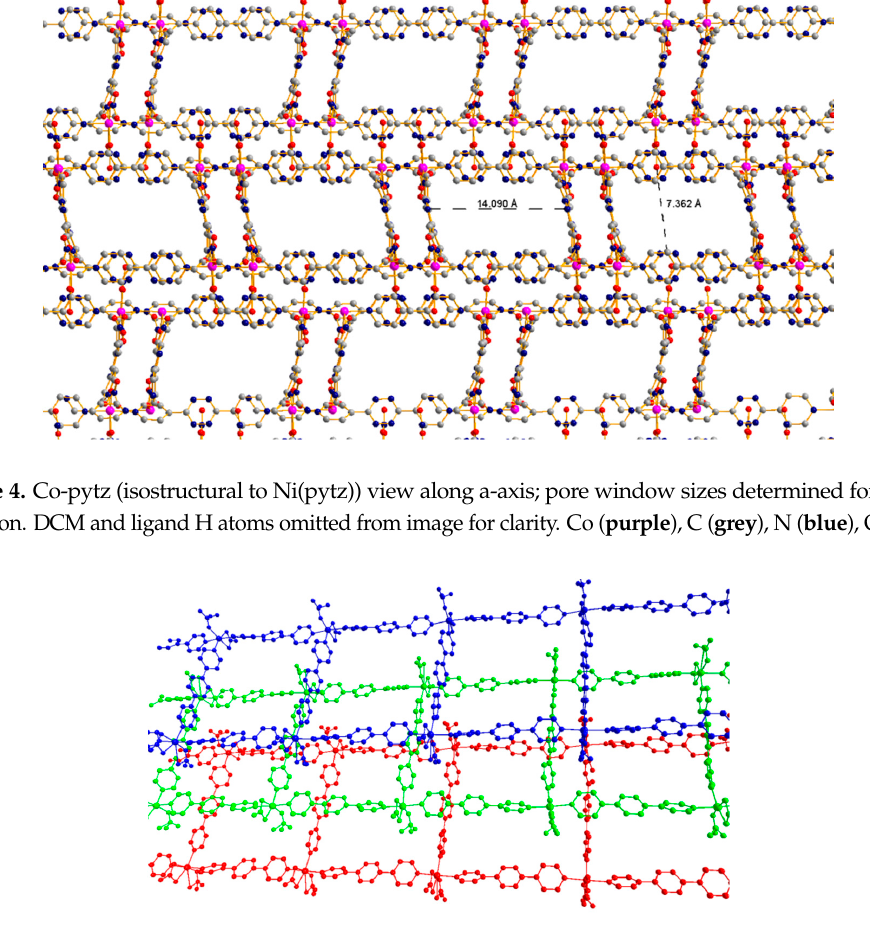
Figure 5. Co-pytz offset layered ladders demonstrating interconnected porosity; front ladder—blue, second—red, third—green. DCM and ligand H atoms omitted from image for clarity.